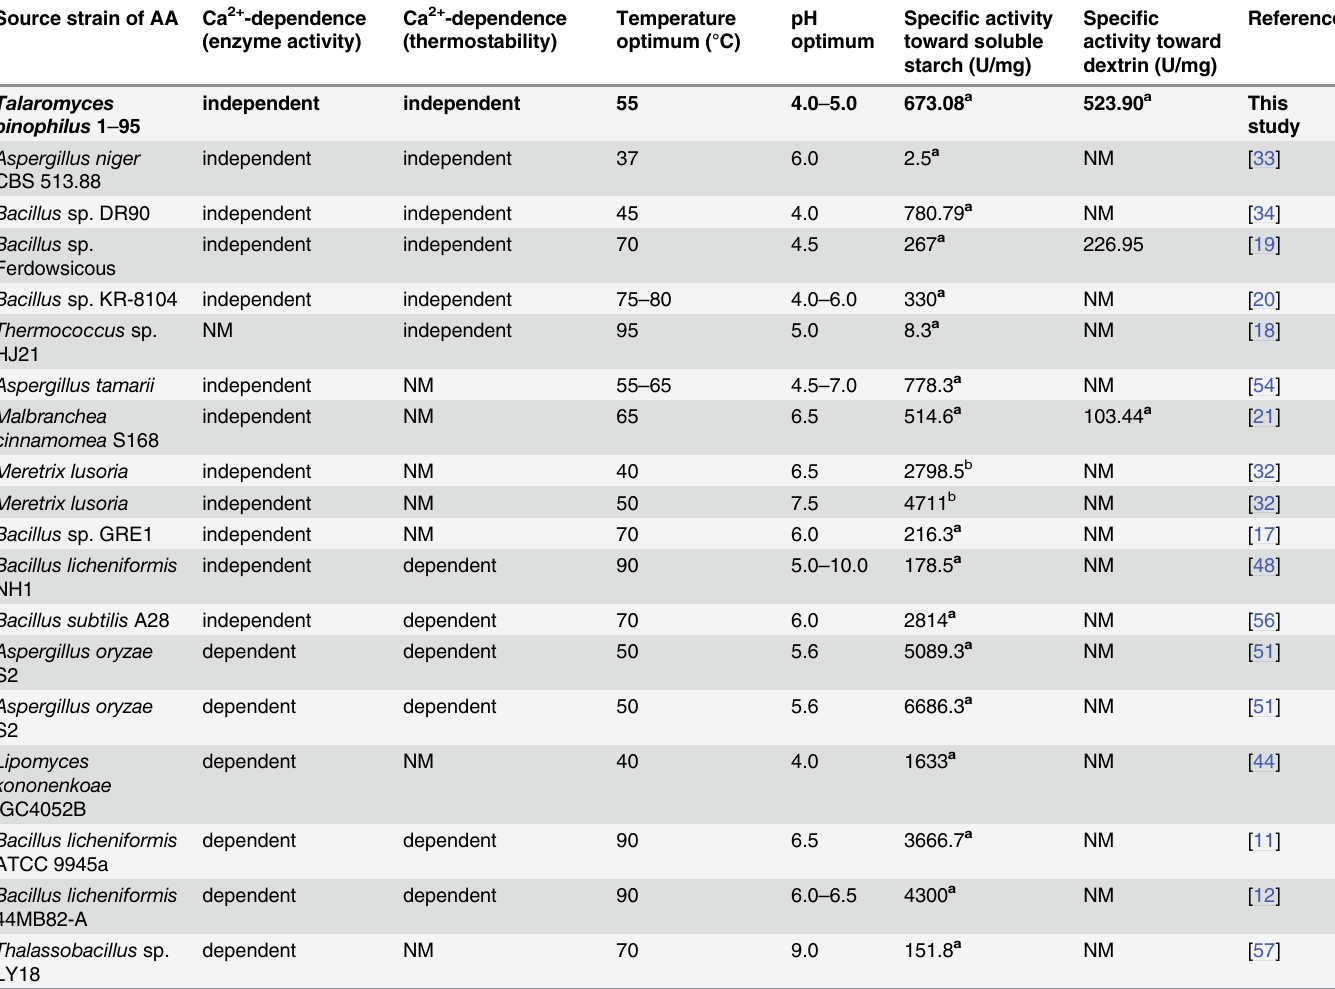
Table 6. Comparison of enzymatic characteristics among TpAA and previously reported α -amylases. Source strain of AA Ca 2+ -dependence (enzyme